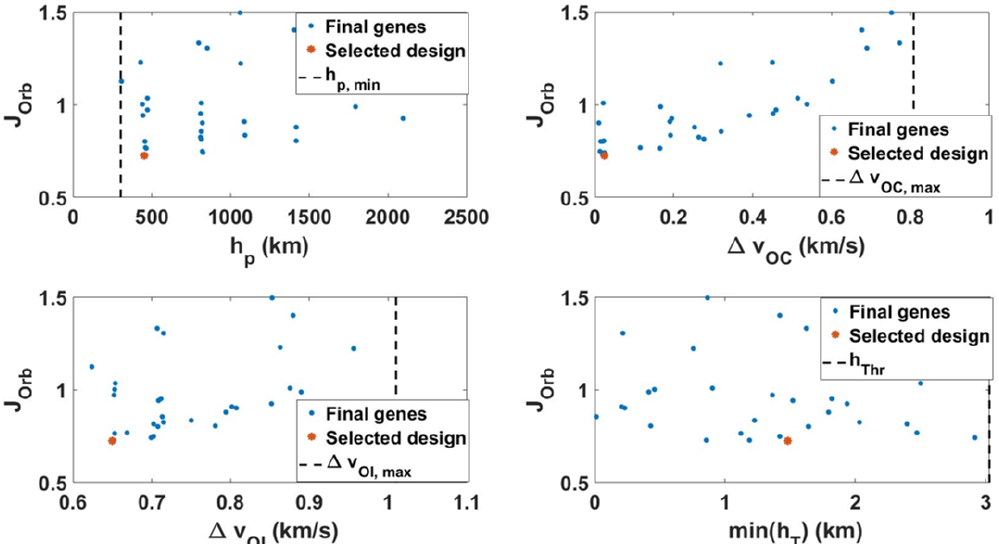
Figure 16. The figures of merit of the co-orbit design problem along with the selected optimal